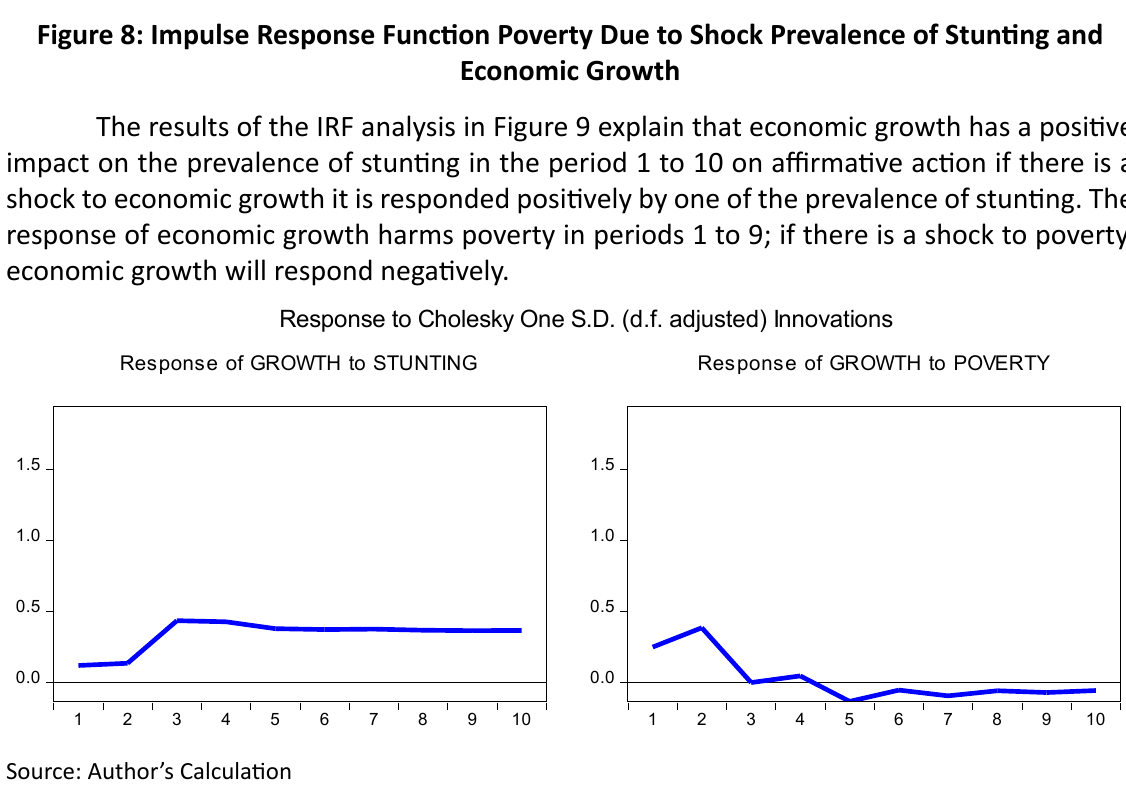
Figure 9: Impulse Response Function Economic Growth Due to Shock Prevalence of Stunt- ing and Poverty Forecast Error Variance Decomposition